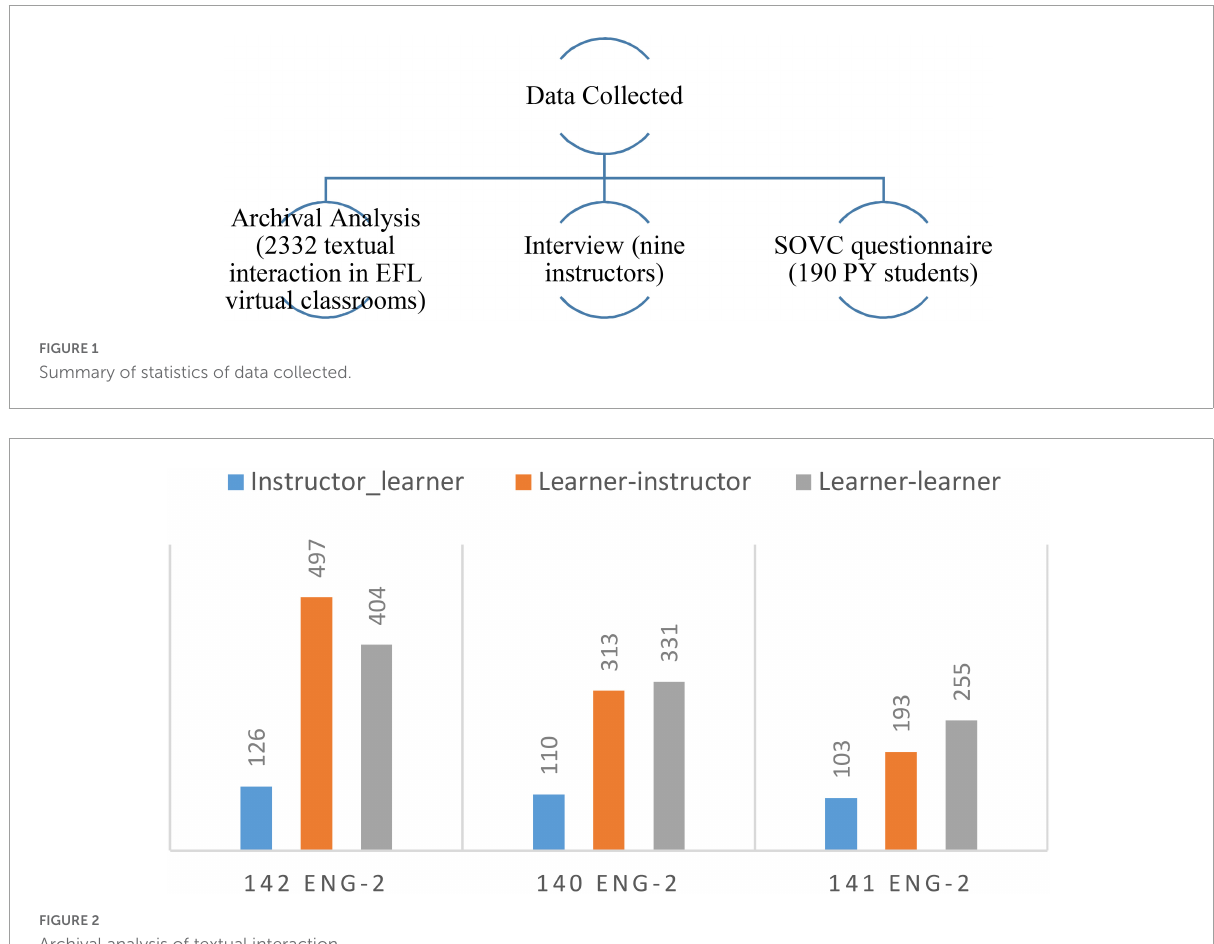
FIGURE2 Archival analysis of textual interaction.